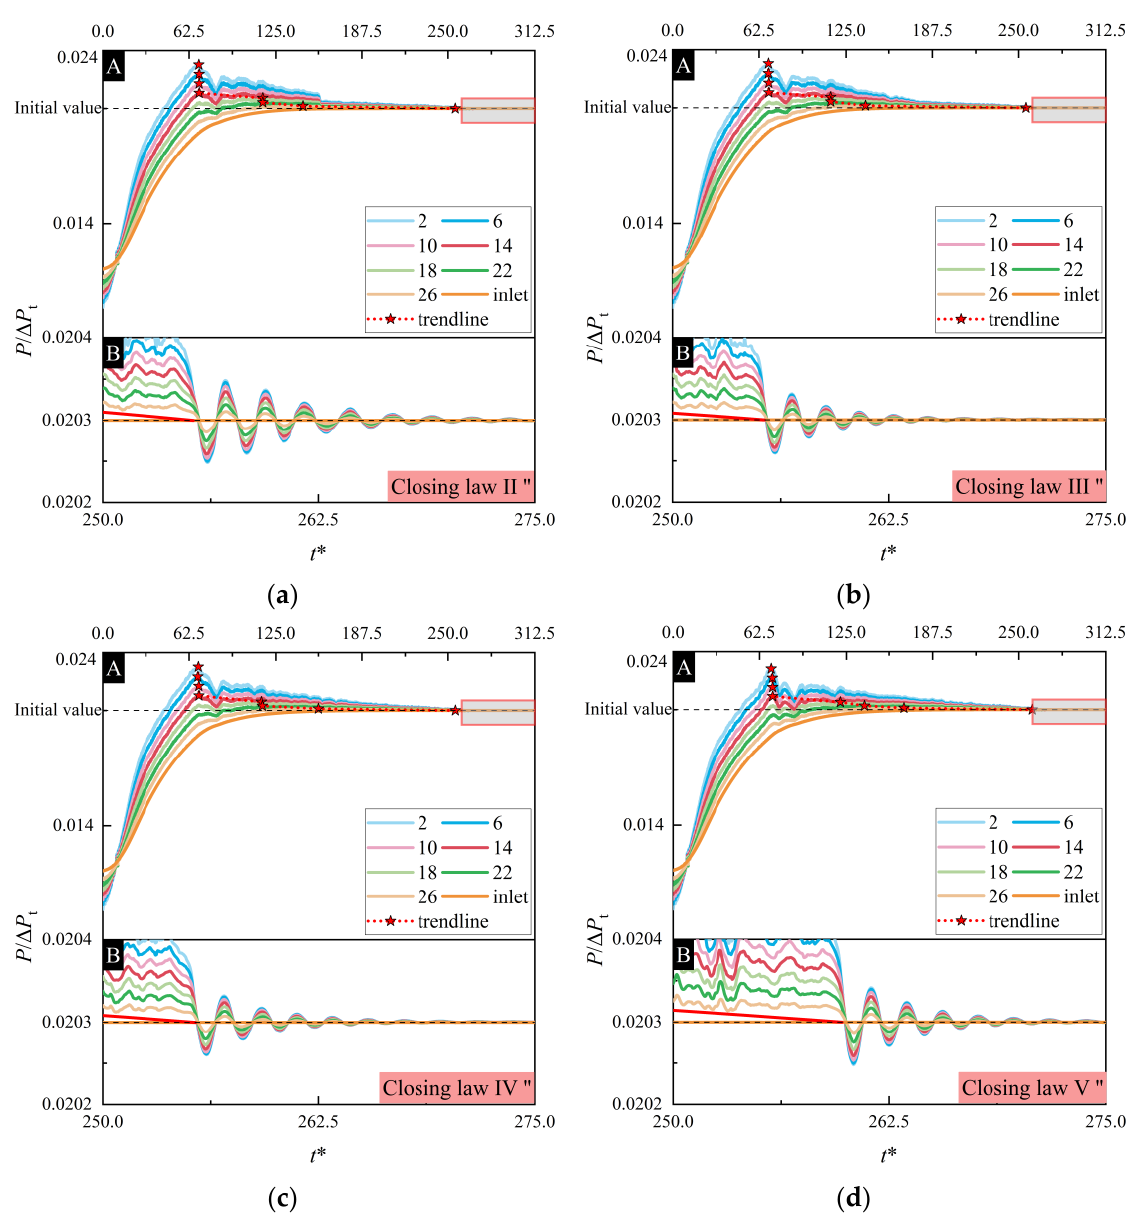
Figure 11. The influence of valve closing laws based on closing time t * = 312.5 on water hammer pressure: ( a ) closing law II ” . ( b ) closing law III ” . ( c ) closing law IV ” . ( d ) closing law V ” .